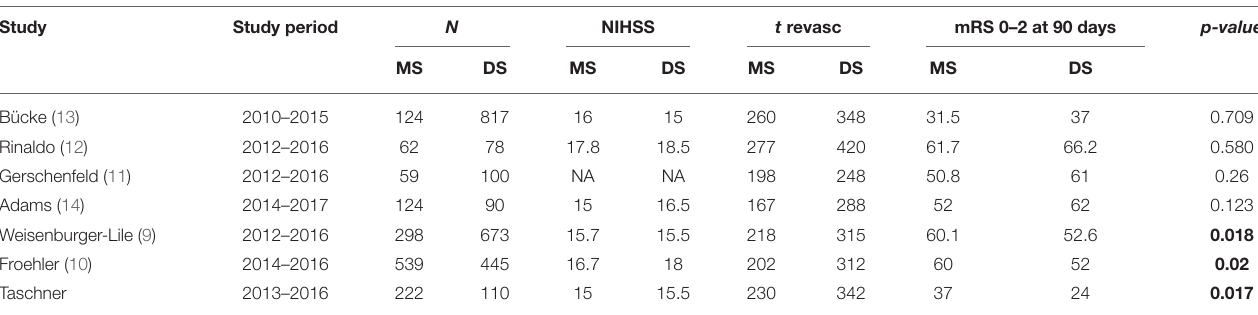
TABLE 3 | Trials comparing drip-and-ship with mothership stroke